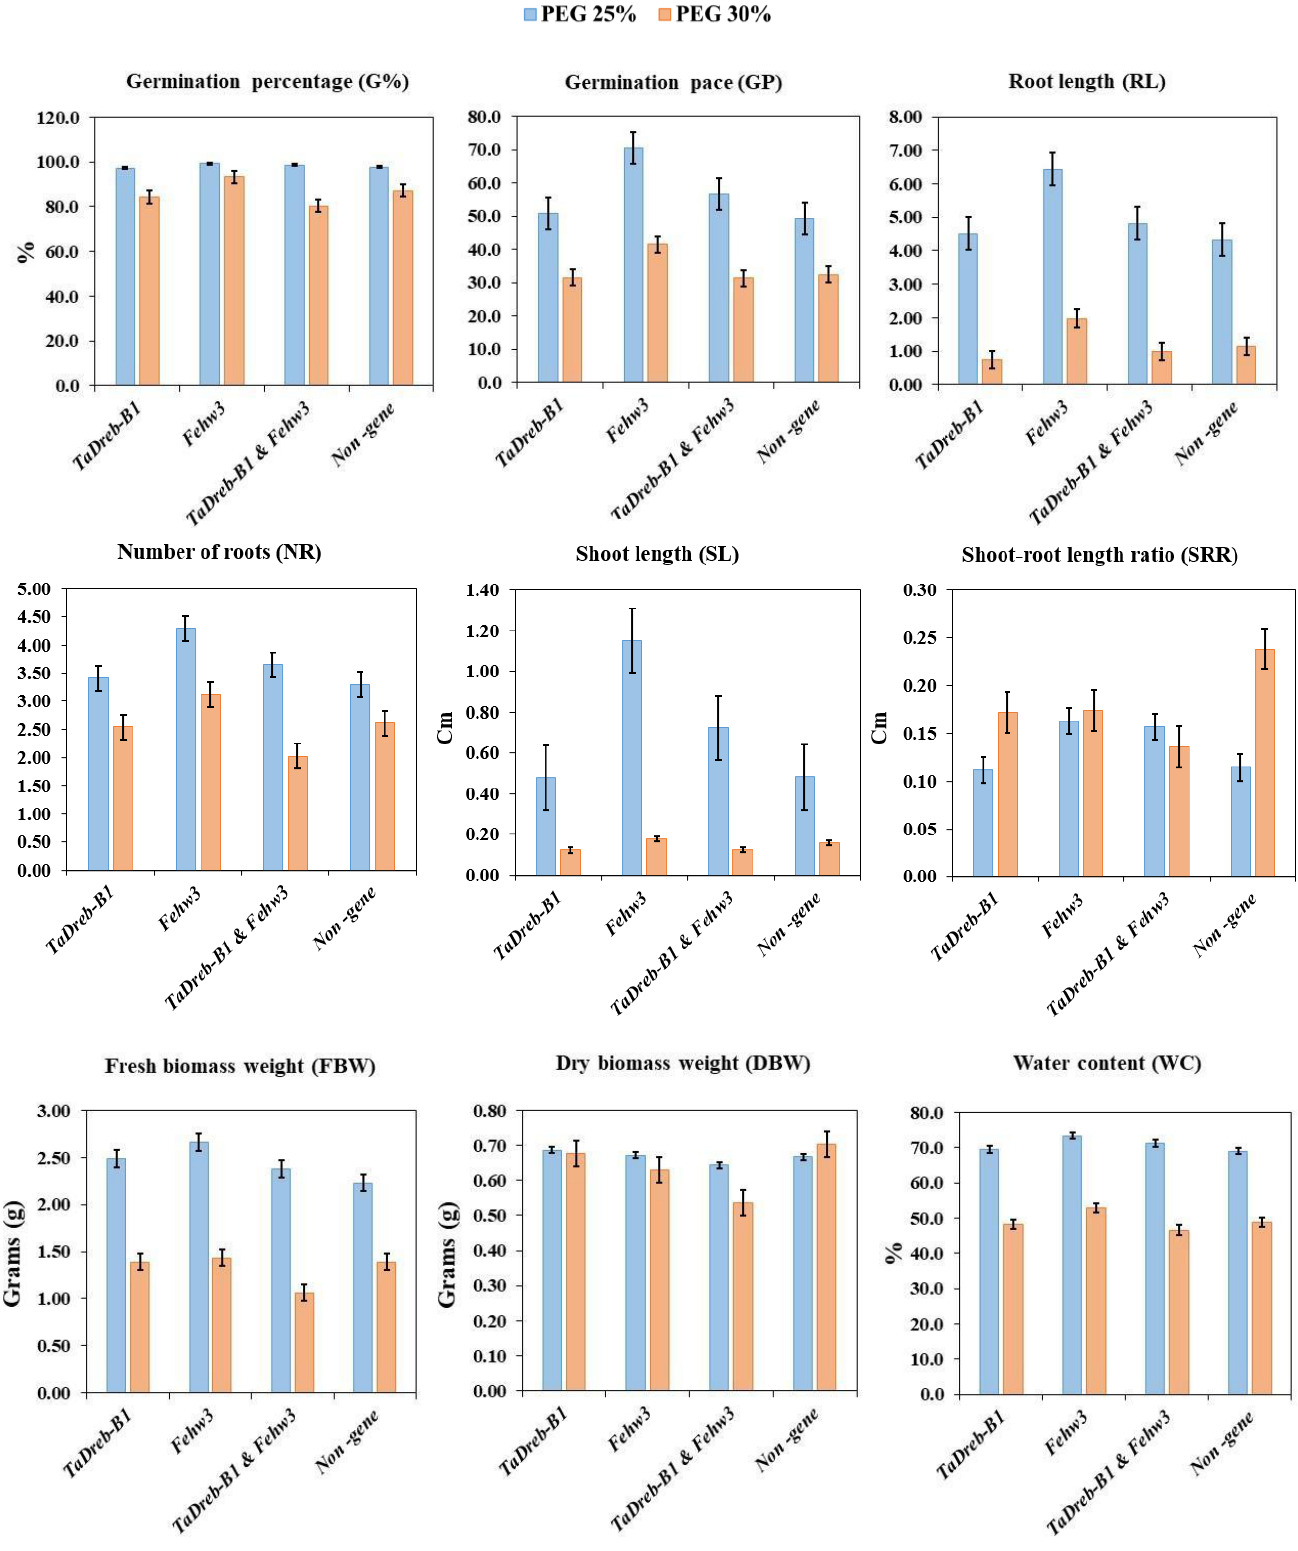
Figure 5. The average of each group for each trait under 25%and 30% of PEG. Ta Dreb-B1 : refers to the genotypes with only TaDreb-B1 allele; Fehw3 : refers to the genotypes with only the Fehw3 allele; TaDreb-B1 and Fehw3 : refers to those genotypes that having both alleles; Non: refers to the genotypes which had any of the two